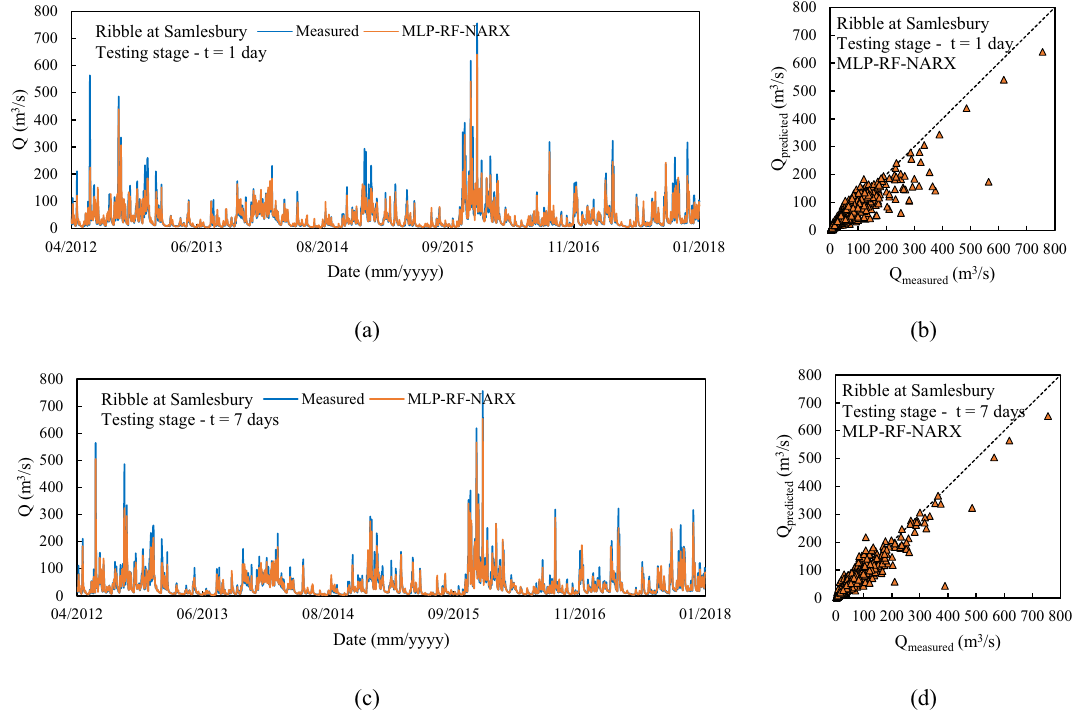
Figure 9. Predictions for Ribble at Samlesbury with MLP-RF-NARX model: t = 1 day ( a , b ); t = 7 days ( c , d ).